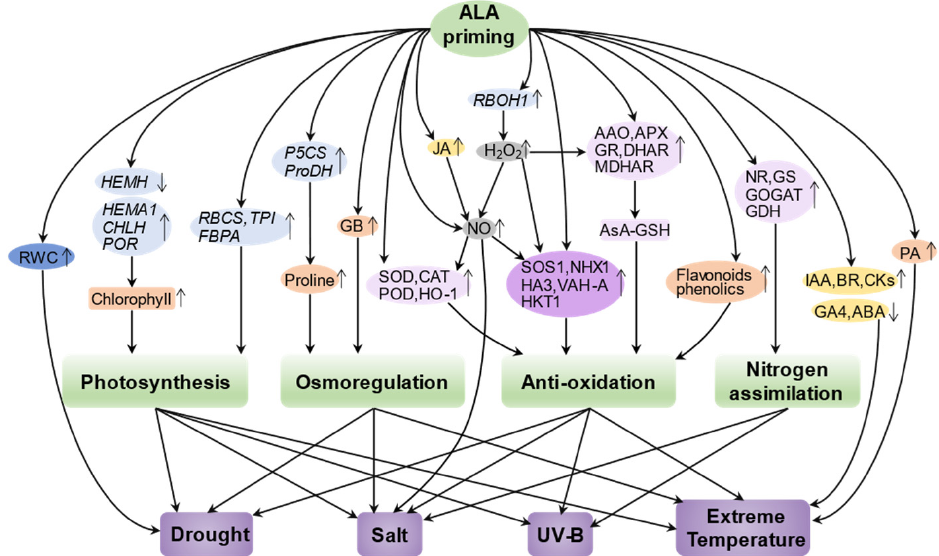
Figure 3. Construction of a regulatory network of ALA priming-mediated abiotic stress tolerance. Priming with ALA enhances the ability of plants to cope with various stresses such as drought stress, salt stress, UV-B stress, and extreme temperature stress by regulating photosynthesis, osmoregulation, antioxidant capacity, and nitrogen assimilation in plants through finely tuning the activities of enzymes (light violet), channel proteins (dark violet), hormones (yellow), signaling molecules (gray), small organic molecules (orange), gene expression (light blue), or physiological levels (dark blue). The upward and downward arrows represent an upregulation or downregulation, respectively. HEMA1, glutamyl-tRNA reductase; CHLH, Mg-chelatase; POR, protochlorophyllide oxidoreductase; NR, nitrate reductase; NiR, nitrite reductase; GS, glutamine synthetase; GOGAT, glutamate synthase; CAT, catalase; SOD, superoxide dismutase; APX, ascorbate peroxidase; GR, glutathione reductase; RWC, relative water content; GDH, glutamate dehydrogenase; P5CS, delta-1-pyrroline-5-carboxylate synthase; HKT1, K + transporter protein 1; NHX1, Na + /H + antiporter; VHA-A, proton pump; GB, glycine betaine; DHAR, dehydroascorbic acid reductase; MDHAR, monodehydroascorbic acid reductase; AsA-GSH, ascorbate-glutathione cycle. Table 1. Effects of ALA priming on the tolerance to environmental stressors.